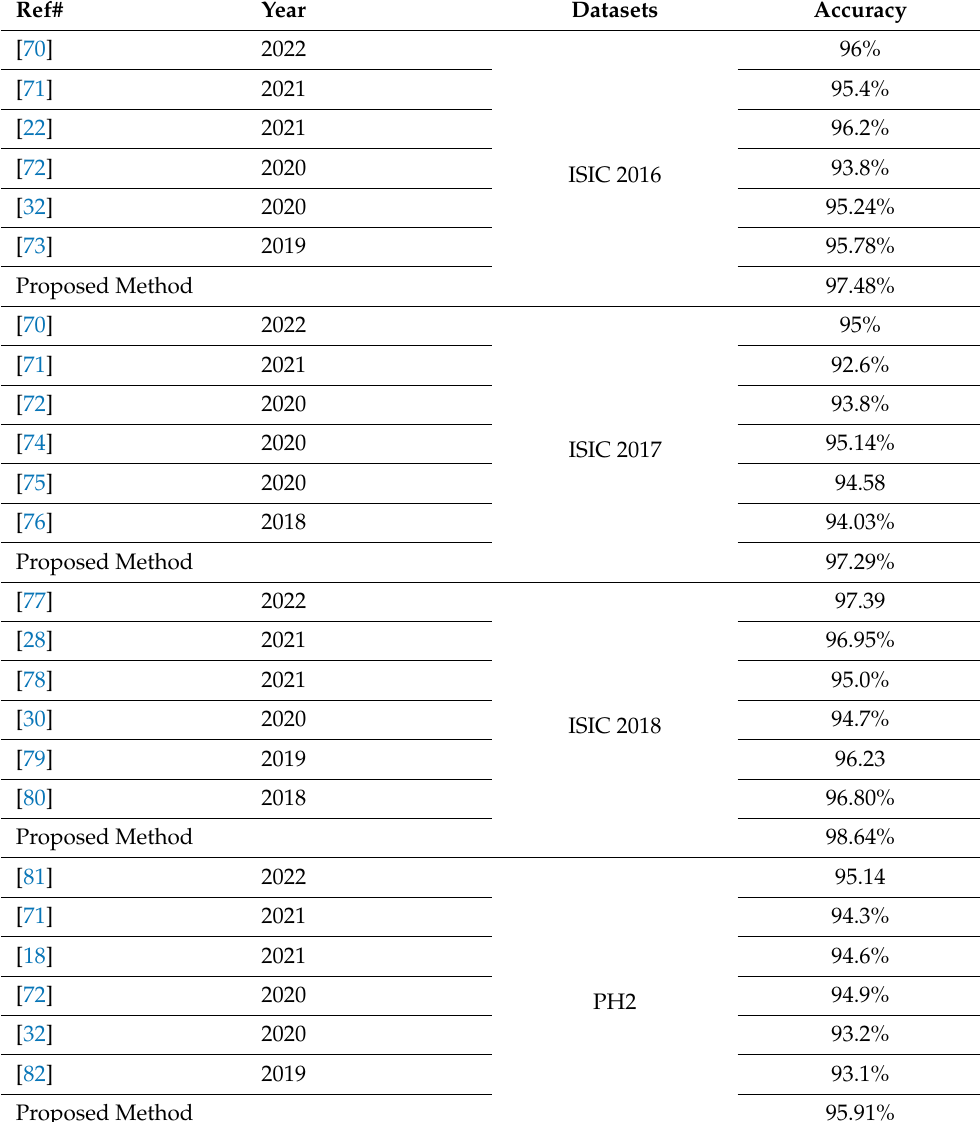
Table 7. Comparison of the existing research works on similar